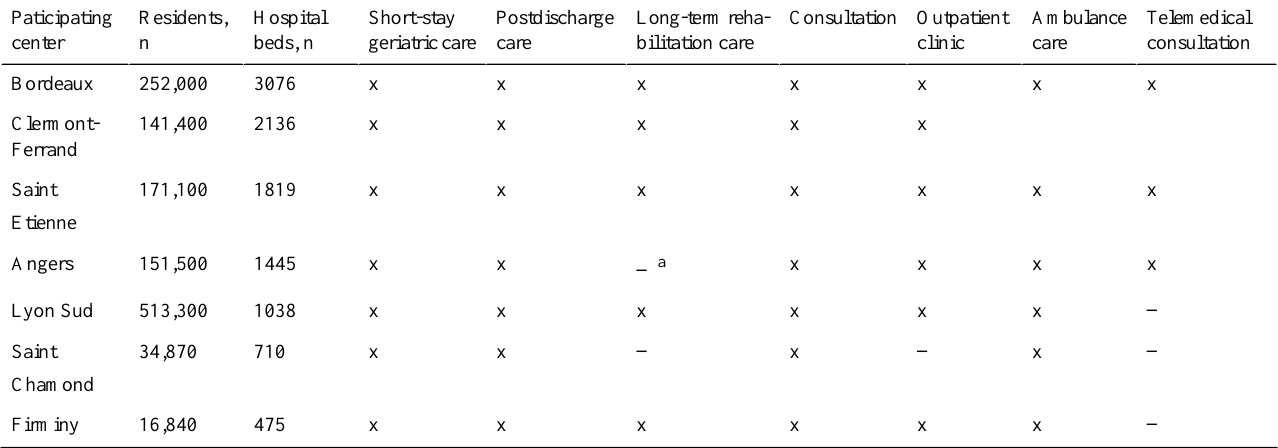
Table 1. Description of geriatric care offered by different participating